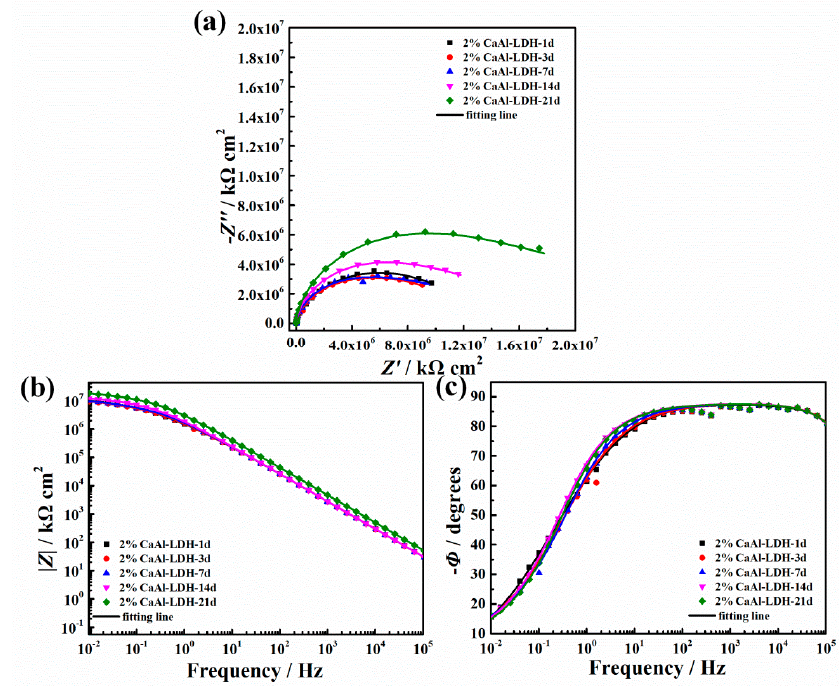
Figure 16. The Nyquist and Bode plots of the epoxy coating with addition of 2% CaAl-LDH during an immersion of 21 d. ( a ) Nyquist plots; ( b ) Impedance-frequency Bode plots; ( c ) Phase-frequency Bode